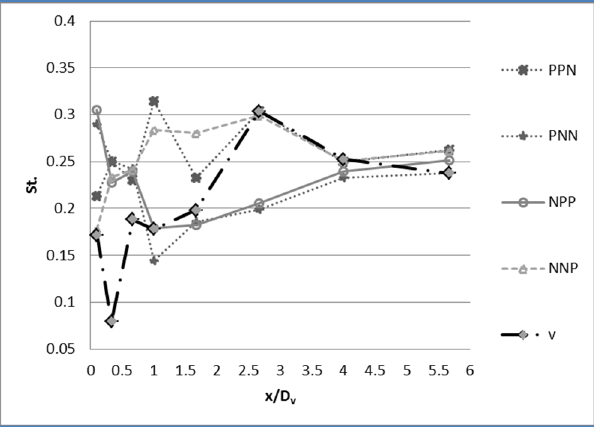
Figure 9. Strouhal Number calculated via the frequency of the bursting events and v.